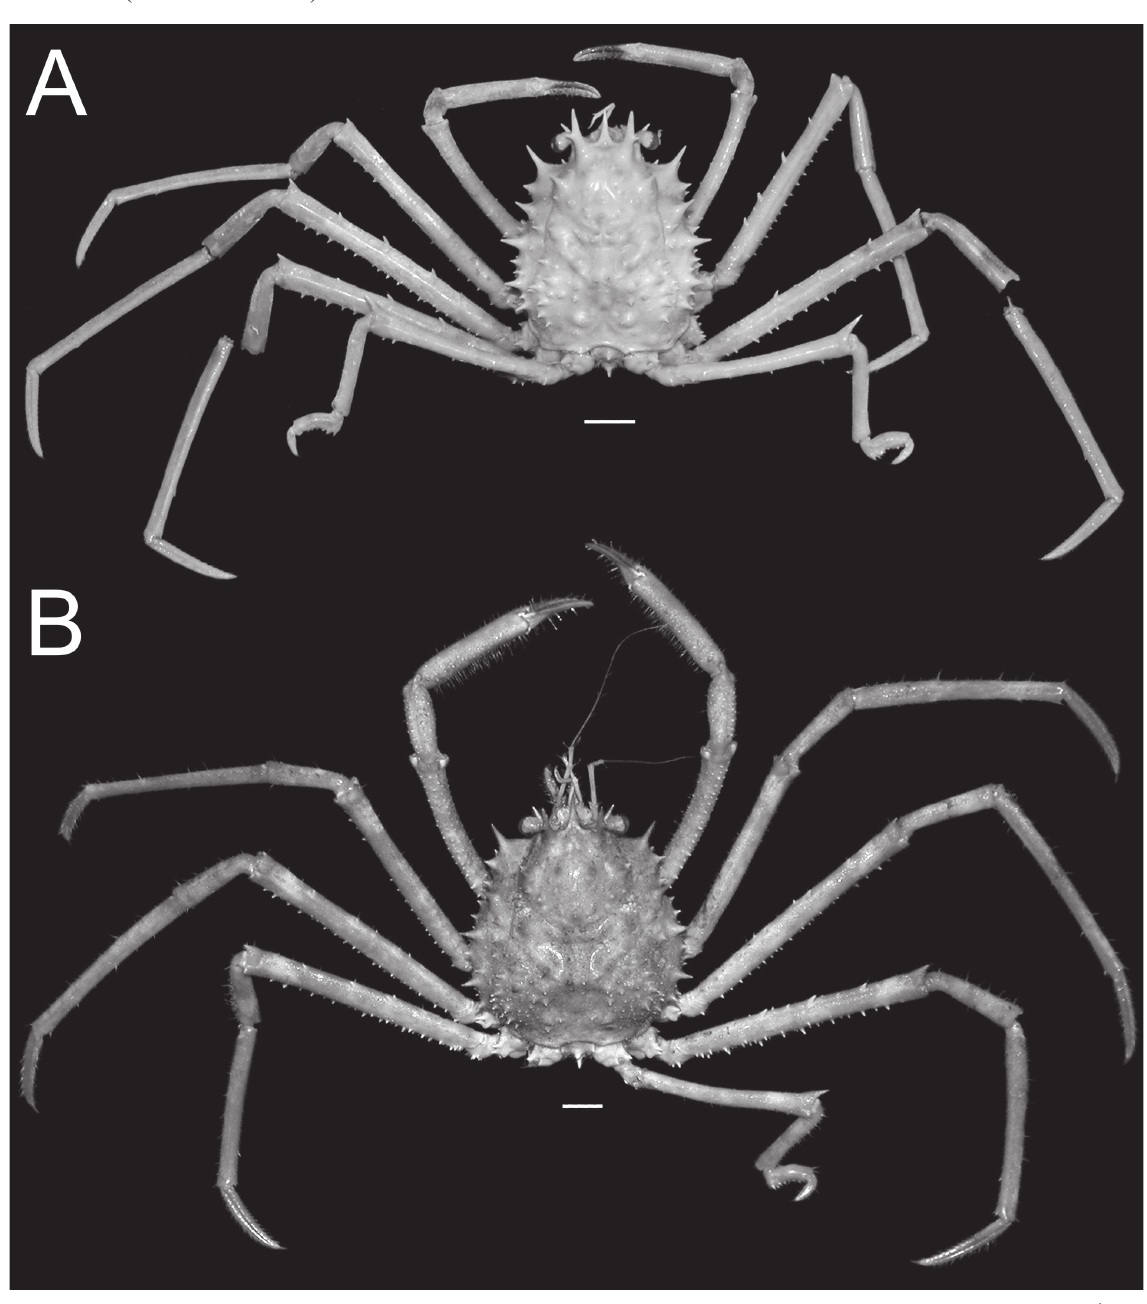
Fig. 1. Overall habitus. A . Moloha grandperrini Guinot & Richer de Forges, 1995. Holotype, ♂ (cl 46.5 mm, cw 39.0 mm) (NHM 1948.9.7.27), Maldives. B . Moloha tumida sp. nov. Holotype, ♂